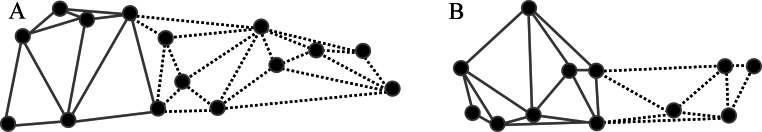
A priori hypotheses tested on C. brevicauda, C. castanea and C. perspicillata for cranial and mandibular modularity.(A) Cranial modularity divides the cranium into neurocranium (grey-solid lines) and splachnocranium (black-dotted lines). (B) Mandibular modularity divides the jaw into ascending ramus (grey-solid lines) and alveolar region (black-dotted lines).